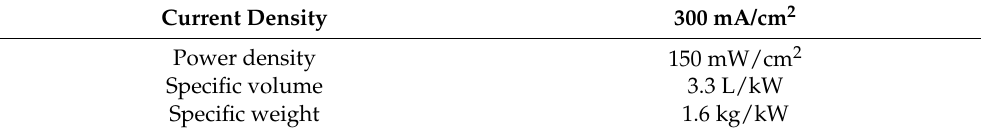
Table 10. Characteristics of SOFC.